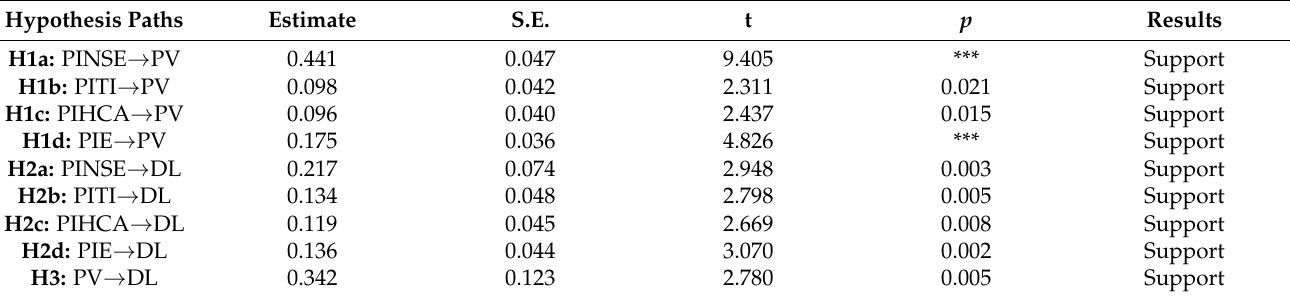
Table 4. Standardization path coefficients and results of testing the hypotheses.